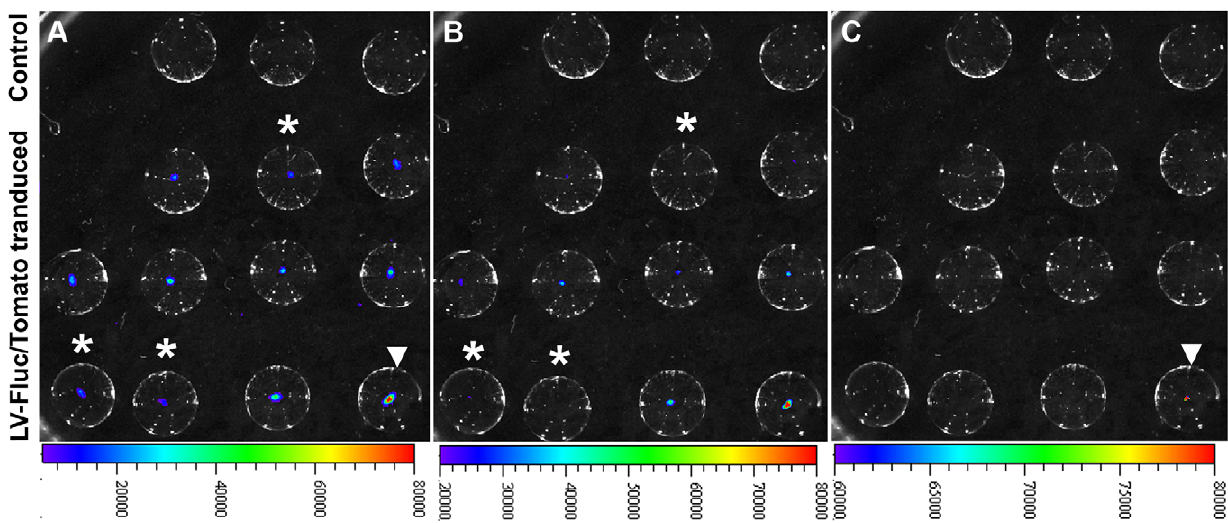
Figure 5. Selection of blastocysts for optimal lentivirus transfection efficiency. Each LV-Fluc/Tomato transduced blastocyst was incubated in KSOM containing D-luciferin (50 ug/ml) and assessed for Fluc expression (luciferase activity) by BLI. A, wide variations in Fluc signals from different blastocysts despite identical virus transfection conditions; B–C, blastocysts with BLI values between 2.0E + 4 and 6.0E + 4 p/s/cm 2 /sr were selected for transfer. Increase of BLI threshold to 2.0E + 4 p/s/cm 2 /sr identifies blastocysts with low signals (B, *), and further increase in threshold to 6.0E + 4 p/s/ cm 2 /sr identifies blasocysts with very high intensity signals (C, . ).